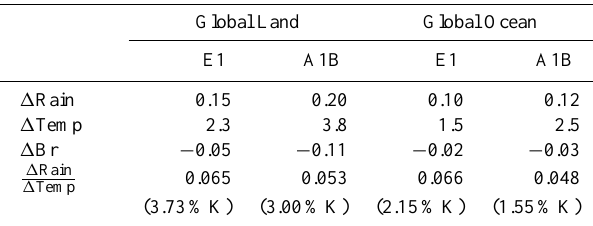
Table 1. Change in (1st row) precipitation, (2nd row) temperature, (3rd row) Bowen ratio (Br) and (4th row) ratio of rainfall vs. tem- perature change for 2071–2100 and with respect to 1970–2000 cli- matology. Global land (ocean) averages in left (right) columns.